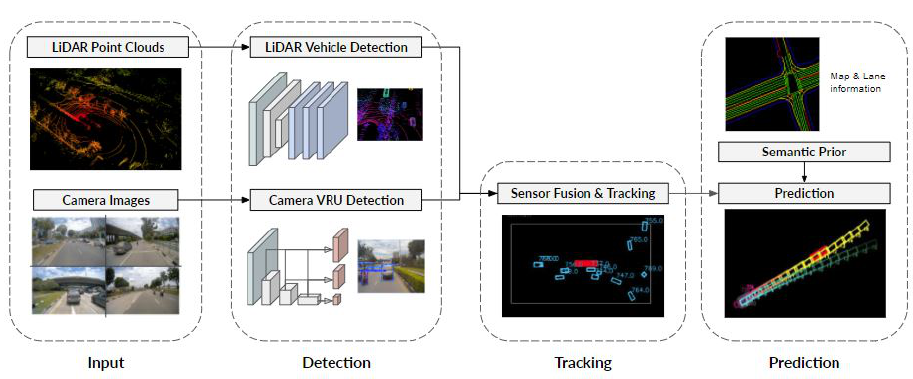
Figure 2. Our prediction pipeline: The inputs of the pipeline are LiDAR and camera sensors mounted on the autonomous bus. Further discussion of the input data and sensors used is given in Section 3. Details on the semantic prior input are discussed in Section